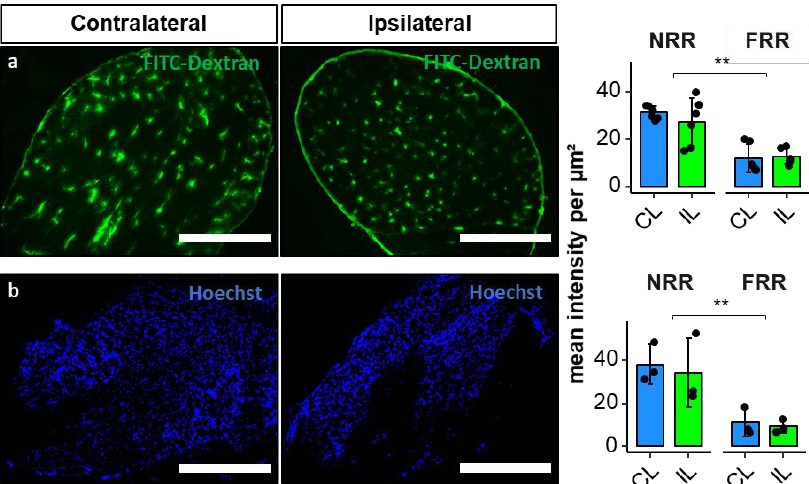
Figure 7. Blood–DRG barrier (BDB) permeability for large molecules in the NRR is higher compared to FRR of DRGs, but has no change after CCI. Wistar rats after 7 d CCI were perfused with